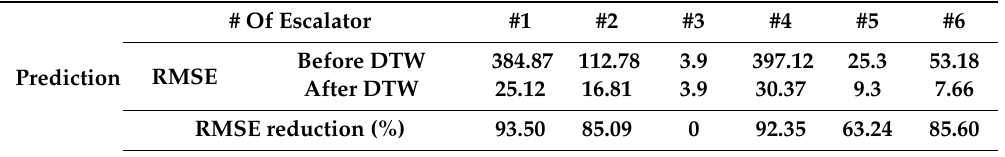
Table 4. RMSE in prediction